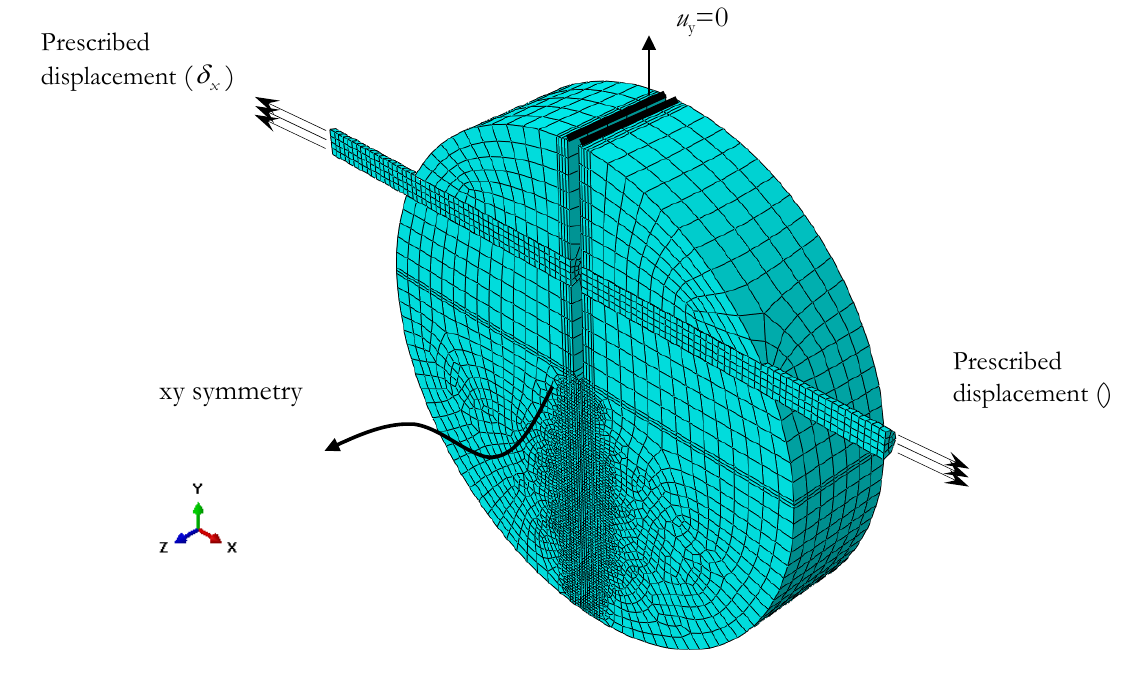
Figure 7: Mesh and boundary conditions for model